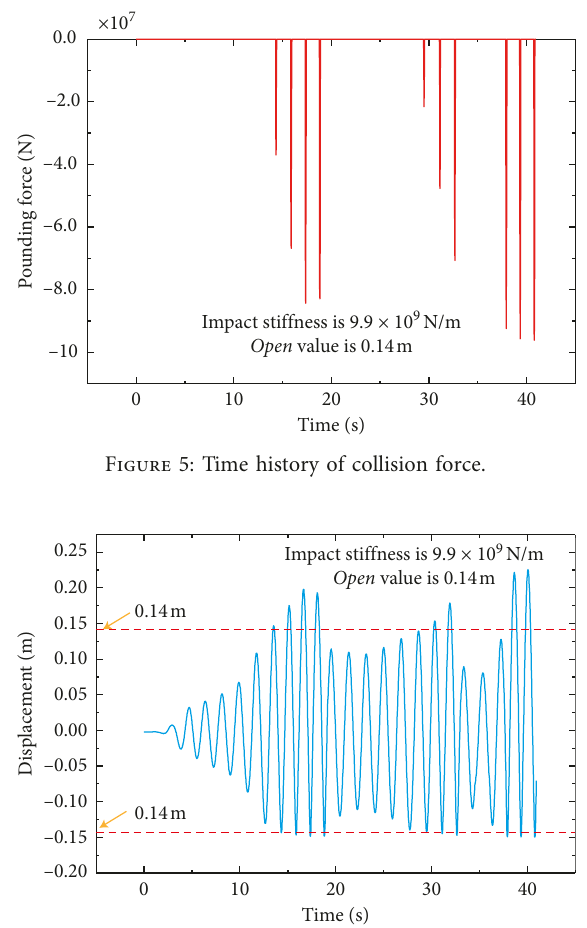
Figure 6: Longitudinal relative displacement response.